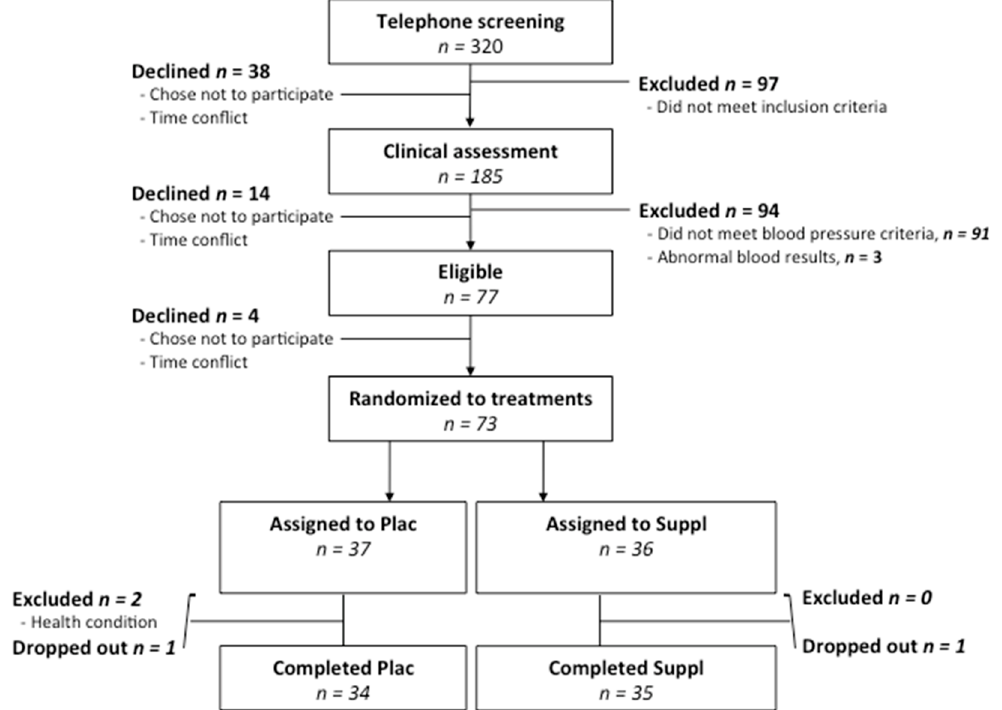
Figure 1. Flow diagram of study participants with prehypertension randomly assigned to a placebo (Plac) or a polyphenol extract and L-citrulline supplement (Suppl). Table 1. Characteristics at screening of all participants with prehypertension randomly assigned a placebo (Plac) or a polyphenol extract and L-citrulline supplement (Suppl) ( n = 73) 1 . Plac Suppl n = 37 n = 36